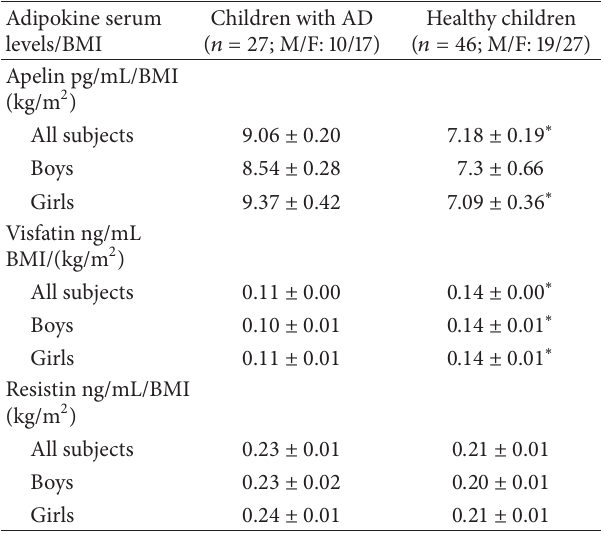
Table 3: The adipokine serum levels/BMI ratio in AD children and healthy